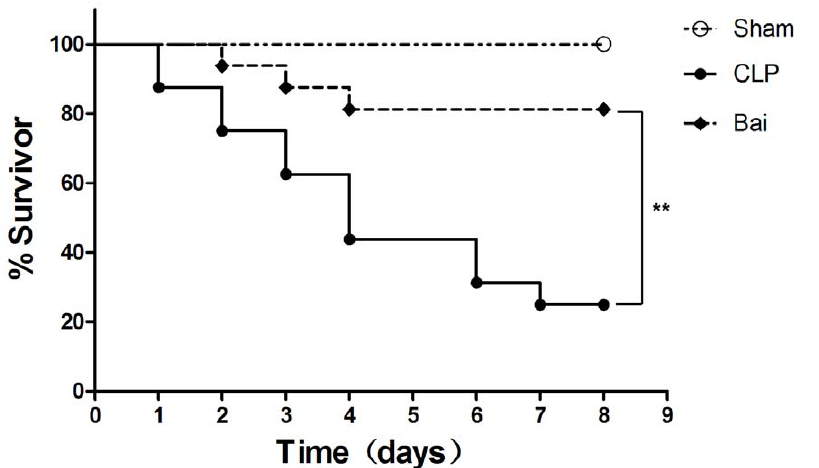
Figure 1. Survival rate of septic mice after injection with baicalin. Baicalin improves survival of polymicrobial sepsis in CLP mice. In the bai group, mice were treated with intra-peritoneal baicalin (100 mg/kg) at 1 h, 6 h and 12 h after CLP. Normal saline of equal volume was administered in sham and CLP groups. Bai, baicalin group; CLP, CLP group. Survival analyses with log-rank test. ** P , 0.01.